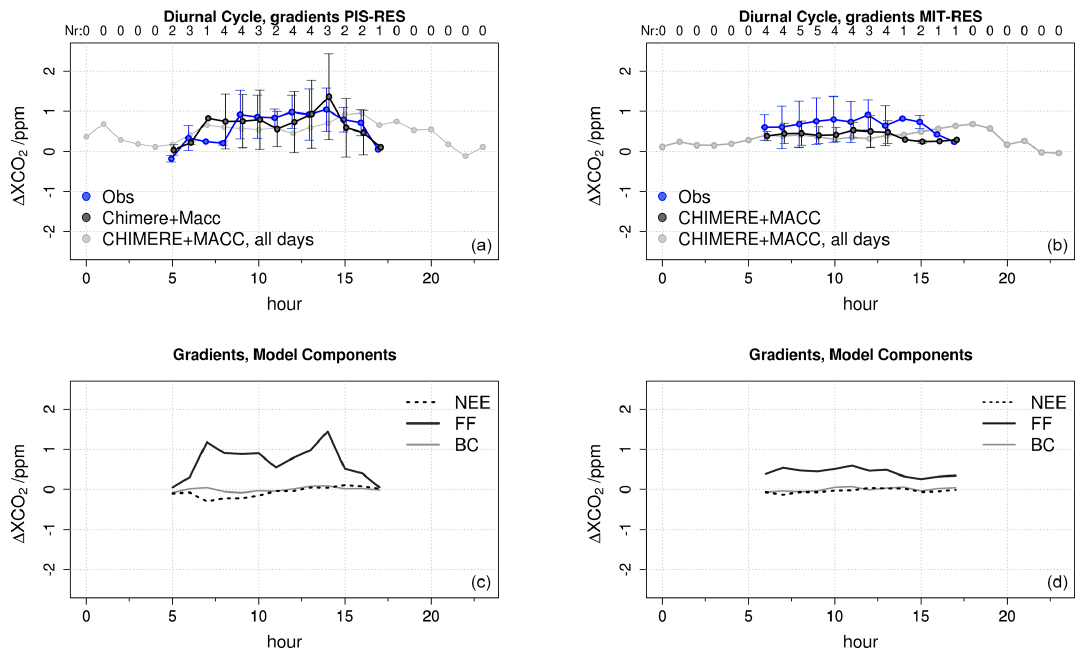
Figure 10. Comparison of modelled (black) and observed mean daily cycles (blue) of hourly averaged (cid:49) XCO 2 of PIS (a) and of MIT (b) during the campaign when RES can be considered an upwind site. Labels at the top of (a) and (b) denote the number of days contributing to the mean. The mean daily cycle for all days within the campaign period when PIS and MIT are downwind of RES is given in light grey. The modelled contribution of different CO 2 sources–sinks to the mean daily cycle for days with observations for the two sites is given in (c) and (d)